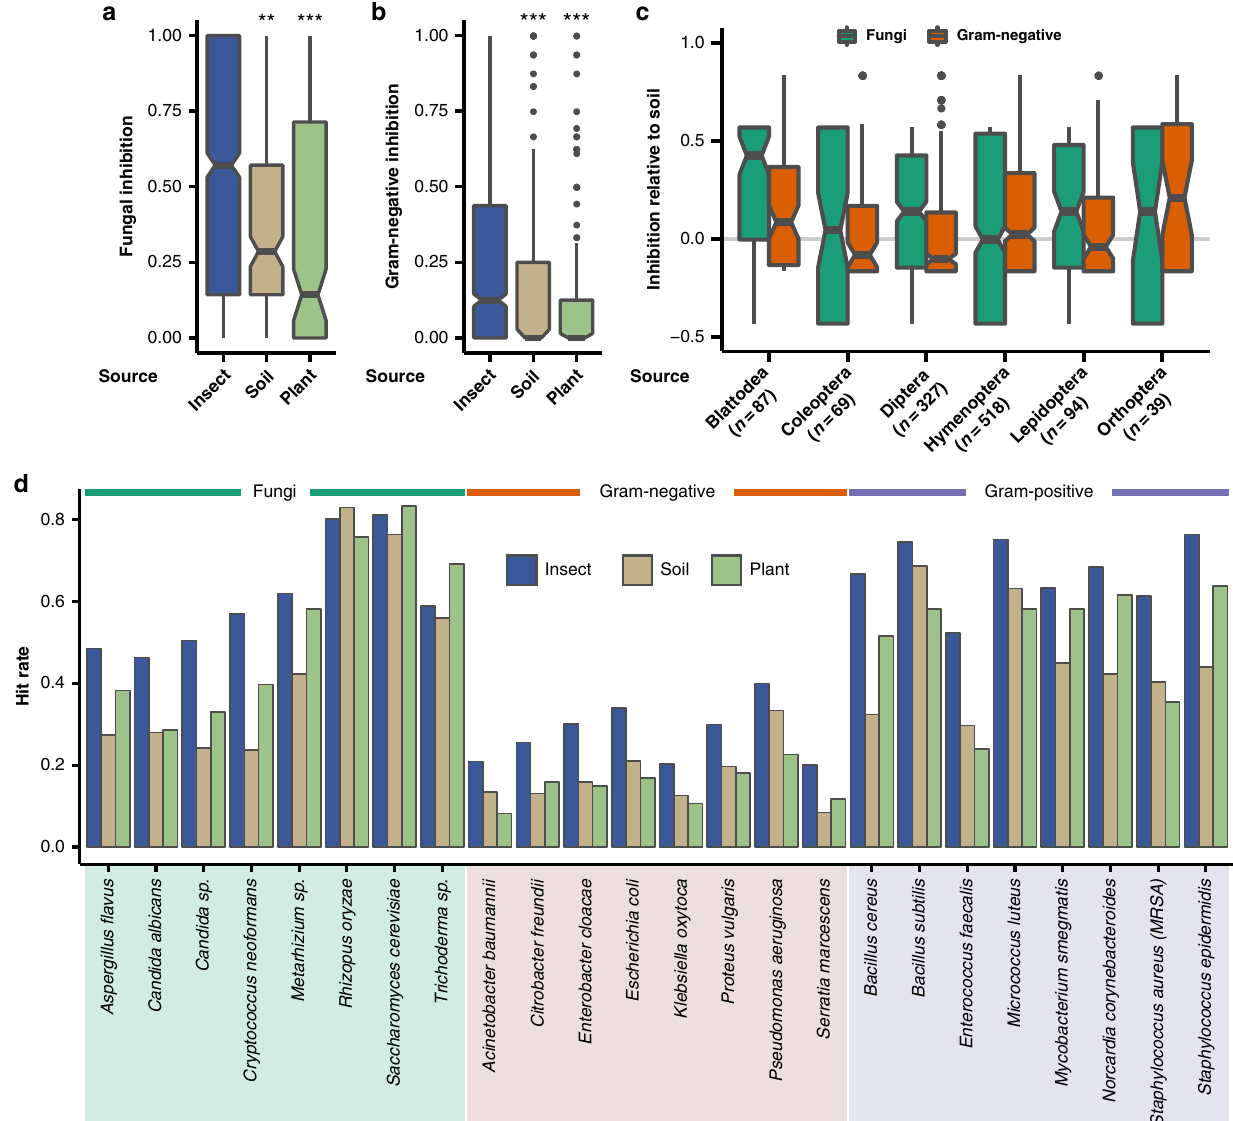
Fig. 3 Bioactivity of insect-associated Streptomyces . a Fungal and b Gram-negative pathogens are signi fi cantly more inhibited by insect-associated isolates compared to soil- and plant-sourced Streptomyces ( n = 1162, 186, and 178 for insect, soil, and plant, respectively; *** p < 1e − 3; ** p < 1e − 2; t -test, BY correction). c Strains vary in antimicrobial bioactivity by insect host orders ( n = 87, 69, 327, 518, 94, and 39 for Blattodea, Coleoptera, Diptera, Hymenoptera, Lepidoptera, and Orthoptera, respectively). a – c : center, median; box, upper and lower quantiles; notches, 95% con fi dence; whiskers, 1.5× interquartile range; points, outliers. d Hit rate for insect, soil, and plant strains against individual pathogens ( n = 1162, 186, and 178 for insect, soil, and plant,